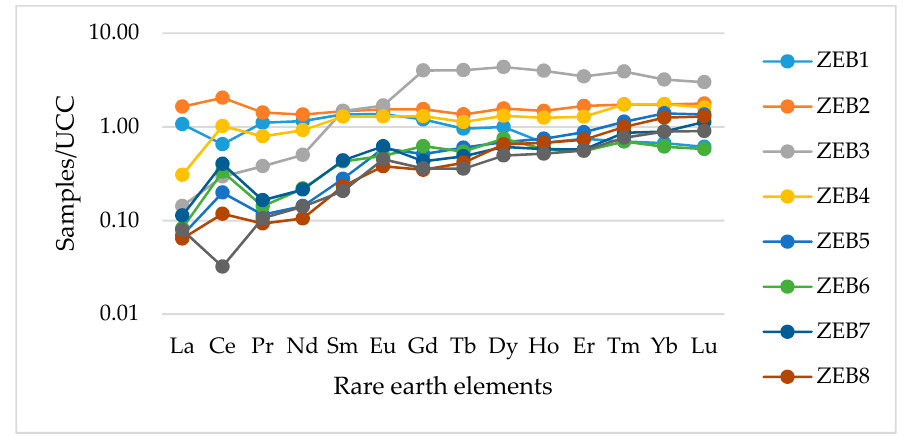
Figure 6. Rare earth element plot of the clay size fraction of the Zebediela kaolin samples compared to the UCC. Table 5. Rare earth element composition in ppm of the clay fraction of the Lwamondo kaolin. Rare Earth Elements